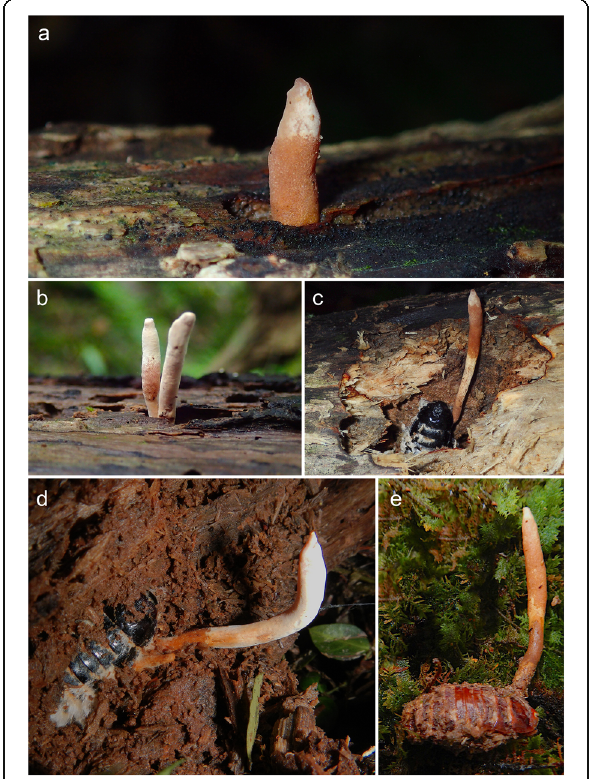
Fig. 2 Ophiocordyceps salganeicola emerging from Salganea esakii in its natural habitat in Yakushima island, Kagoshima. a and b Visible part of the ascoma, emerging from a hole in the wood. c and d Hosts buried in the wood, visible only after digging a few centimeters. e Infected host in its very rare nymphal